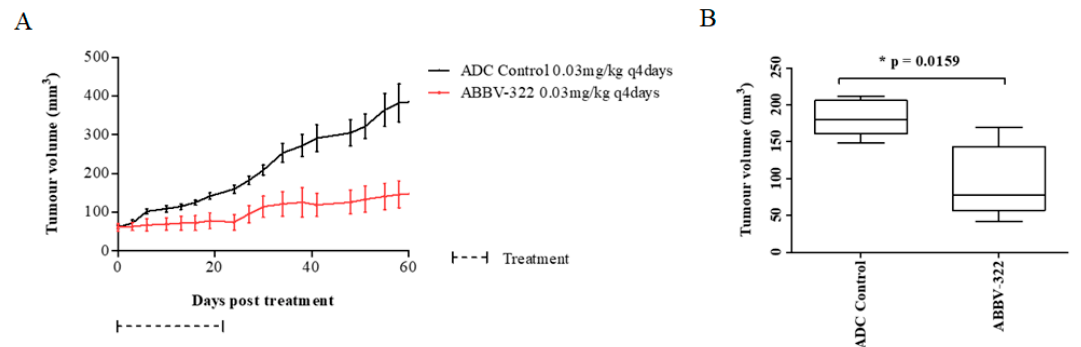
Figure 4. Tumor growth response and survival curves for the 14R091 epithelioid mesothelioma patient-derived xenograft (PDX) model. ( A ) Tumor growth curve of mice treated with ABBV-322 and the ADC control at the doses specified ( n = 5 mice in each group). ( B ) Average tumor volumes from mice at 27 days after treatments were initiated. There was a statistically significant tumor growth inhibition in the ABBV-322 treatment arm on day 27 post-therapy ( p = 0.0159, two-sided) compared to the ADC-pyrrolobenzodiazepine (PBD) control arm. The average tumor volumes were 183 mm 3 (ADC control) and 96 mm 3 (ABBV-322).